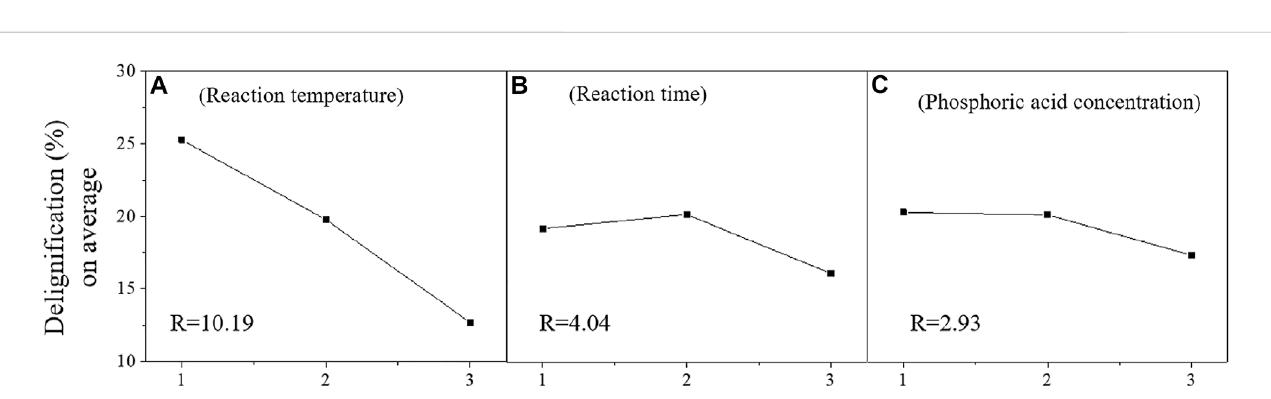
FIGURE 3 Analysis of orthogonal experiment factors on deligni fi cation [reaction temperature (A) , reaction time (B) and phosphoric acid concentration (C) ].